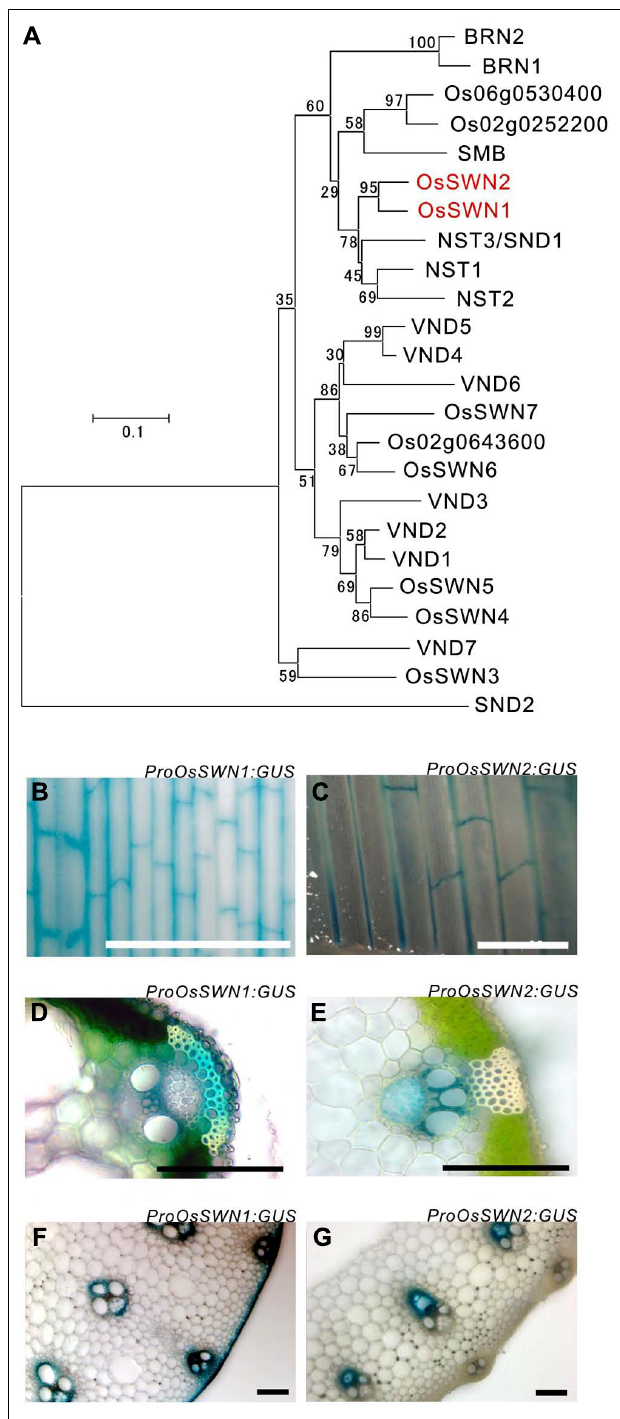
FIGURE 1 | OsSWN1 and OsSWN2 promoters are active in the tissues where secondary walls develop . (A) Neighbor-joining phylogenetic tree of OsSWN proteins and their homologous proteins in rice and Arabidopsis . The number on each branch represents percentage of bootstrap values among 1000 tests. (B – G) GUS stained tissues of ProOsSWN1:GUS rice (B, D, F) and ProOsSWN2:GUS rice (C, E, G) . Leaf (B, C) , section of leaf (D, E) and section of culm (F, G) . Bars represent 1 mm in (B) and (C) , 100 μ m in (D–G)